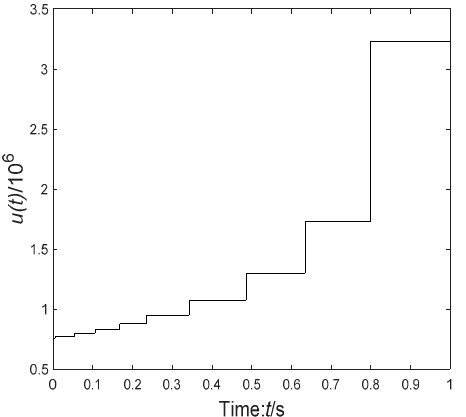
Figure 6. Optimal temperature control trajectory ( N = 10).